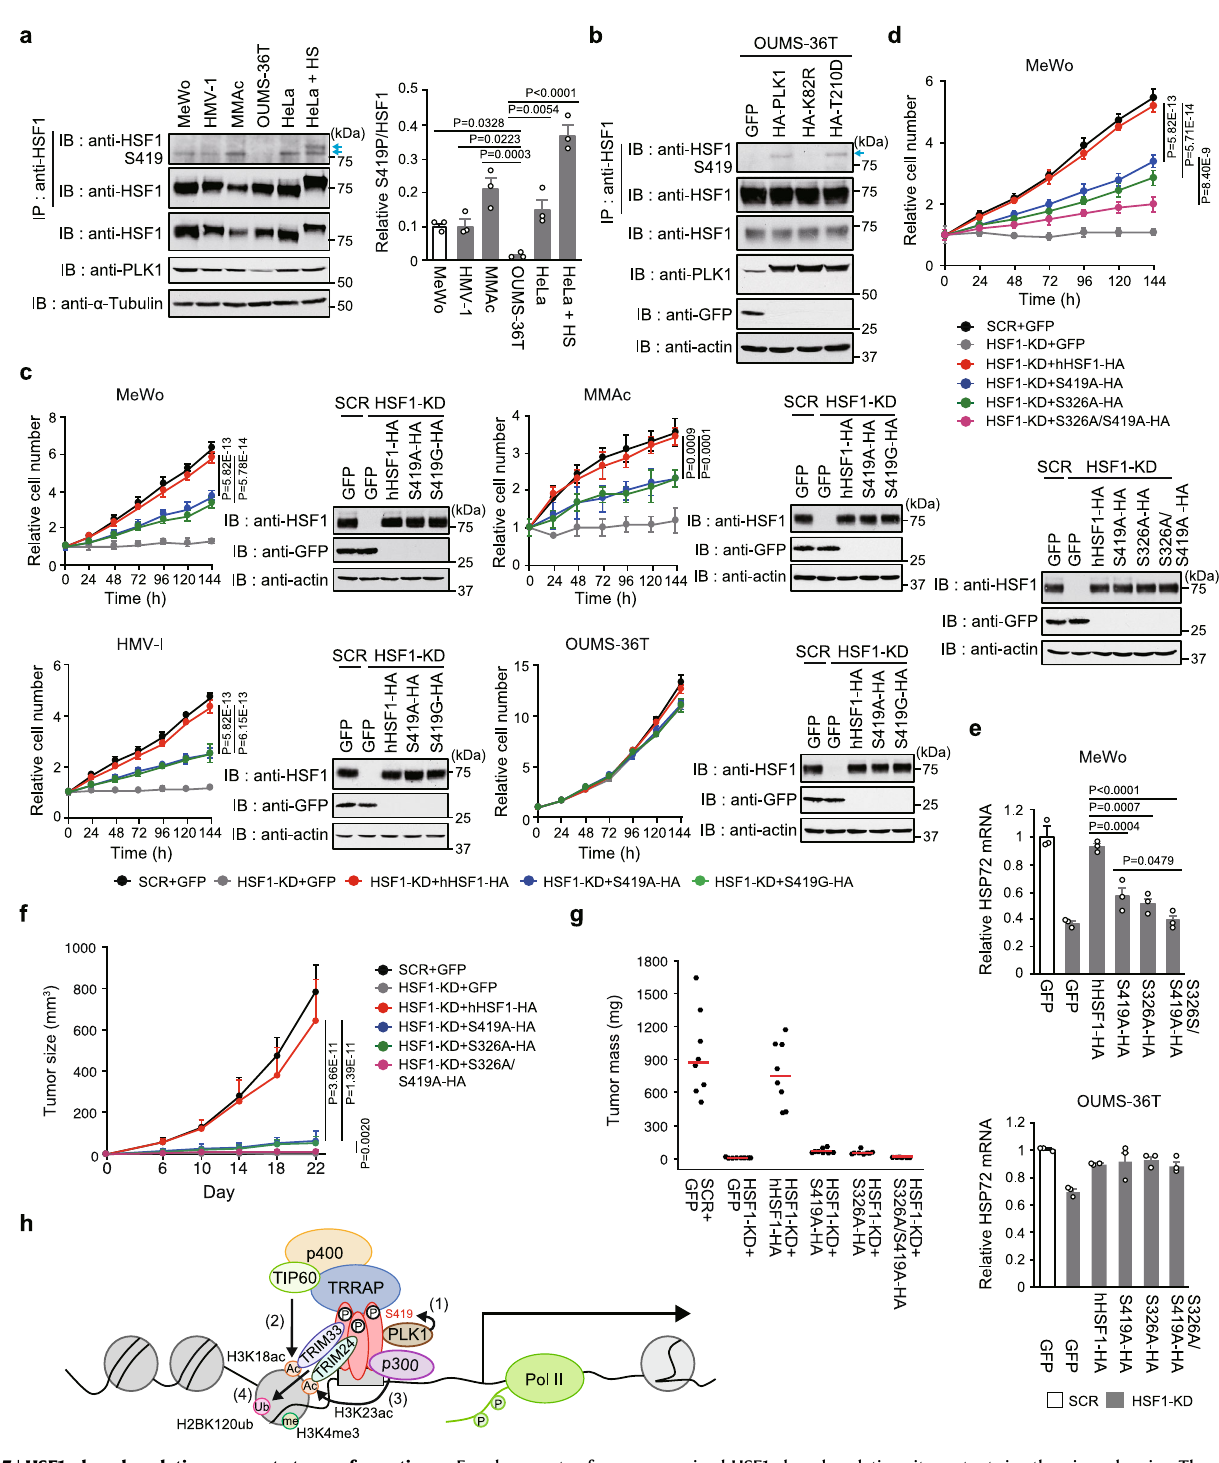
expressinghHSF1phosphorylationsitemutantsinathymicnudemice.Thesizes( f ) and masses ( g ) of tumors at indicated time points after injection were calculated until 22 days. Bars in g indicate mean values ( n =8). h Schematic model for estab- lishing an active chromatin state in HSP72 promoter. PLK1 phosphorylates HSF1- S419(1),whichrecruitstheTRRAP-TIP60complex.TIP60andp300areresponsible forH3K18acandH3K23ac,respectively(2,3).TRIM33andTRIM24,recruitedtothe promoterbyinteractionswithHSF1andthehistoneacetylationmarks,arerequired for H2BK120ub (4). Norminal p values were determined by one-way ANOVA, fol- lowedbyTukey-Kramertestin a and e orbytwo-wayANOVAin c , d and f .Errorbars indicate SEM ( n =3) in a and e , ( n =4) in c and d , or ( n =8) in f . Experiments were repeated two times for b